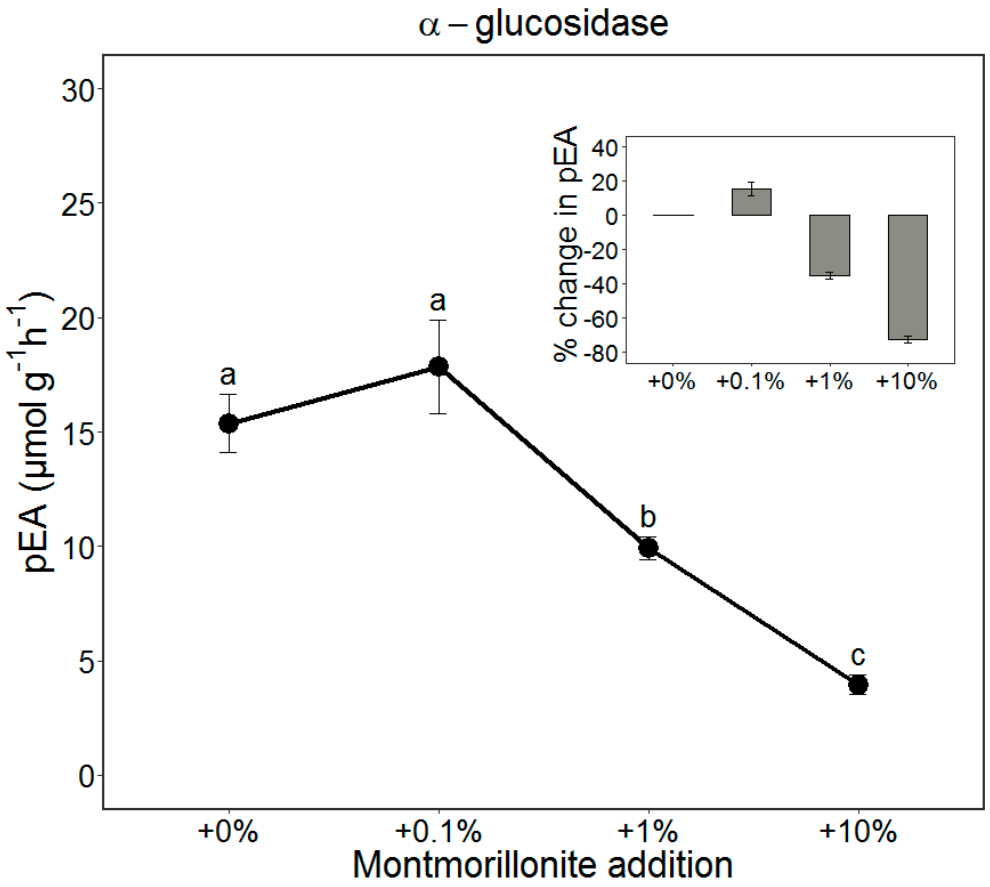
Figure 1. Increasing montmorillonite addition and the effect on potential enzyme activity of pure α -glucosidase. The inset figure presents the change in the pEA relative to the soil with no montmorillonite addition. Bars are standard error of means (n = 3).